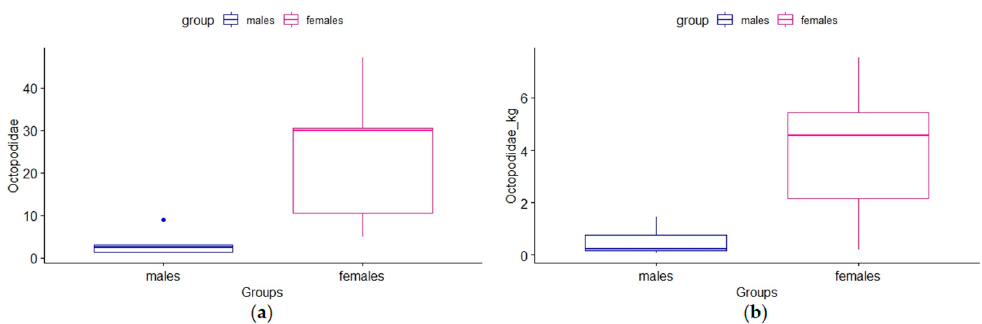
Figure 7. Boxplots of the contribution of Octopodidae in the diet of males and females of bottlenose dolphins: ( a ) numerical and ( b ) weight contribution.